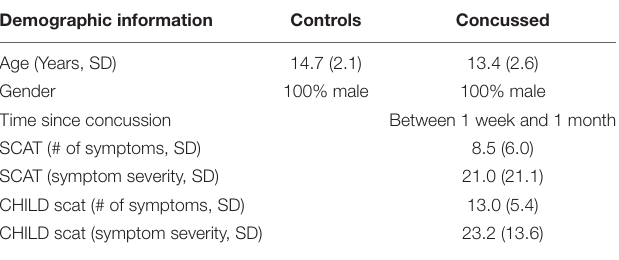
TABLE 1 | Demographic information for the participants in the control and concussed groups. Demographic information